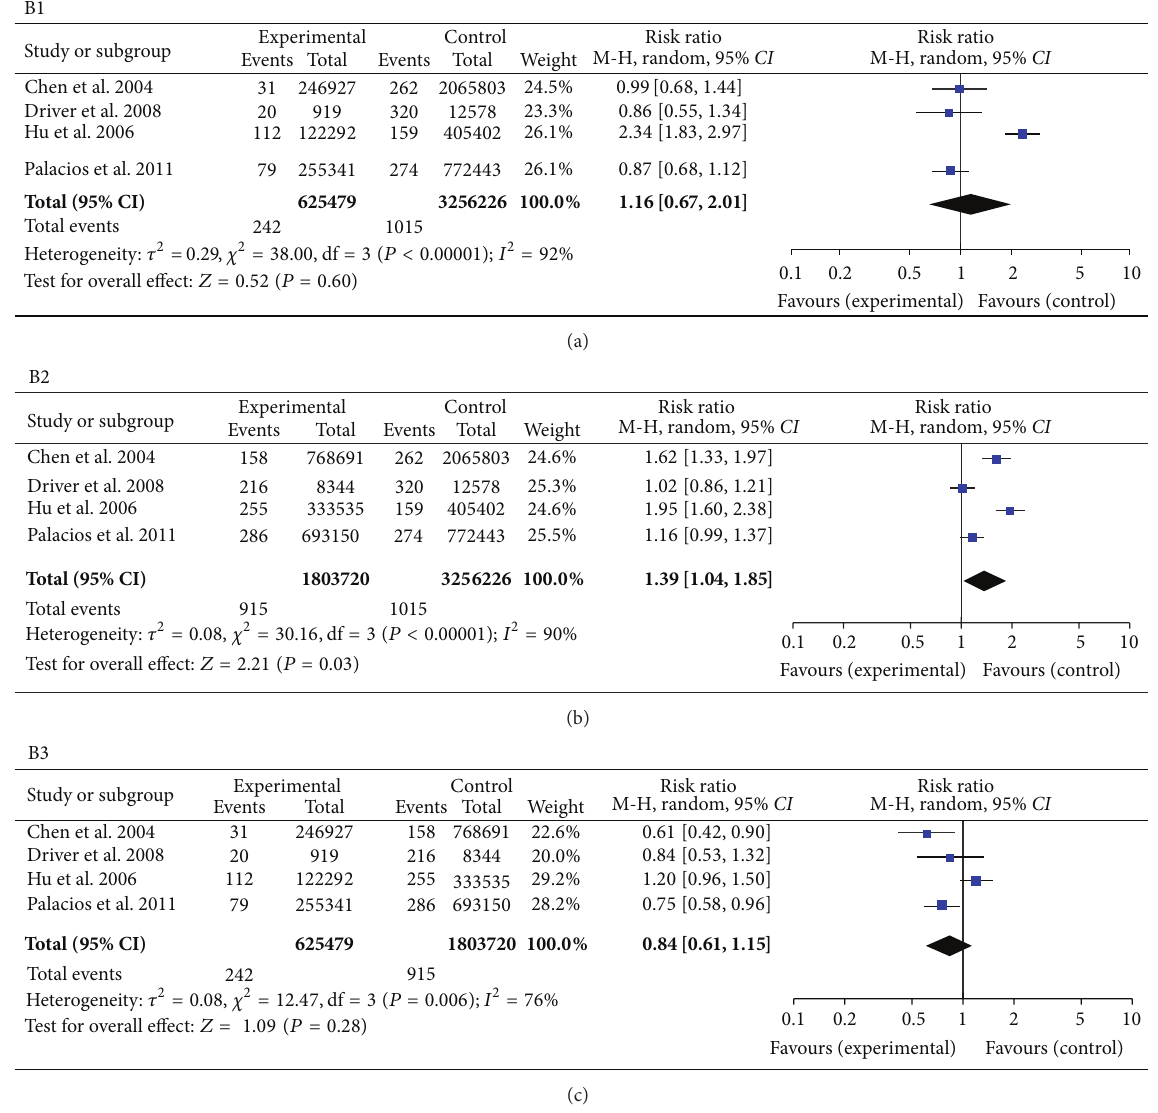
Figure 3: Forest plots for cohort study with all included studies. Meta-analysis of studies reporting BMI and PD versus controls, 95% confidence